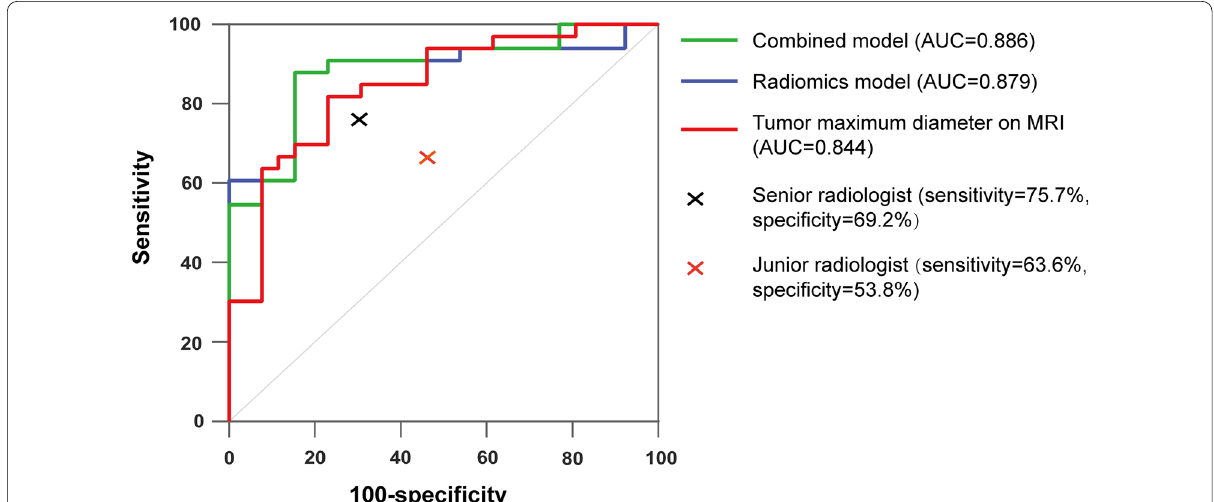
Fig. 3 ROC curves of combined model, radiomics model, and tumor maximum diameter on MRI for predicting middle or deep stroma invasion in the validation cohort. The senior radiologist’s performance is indicated by the black cross and the junior radiologist’s performance is indicated by the red